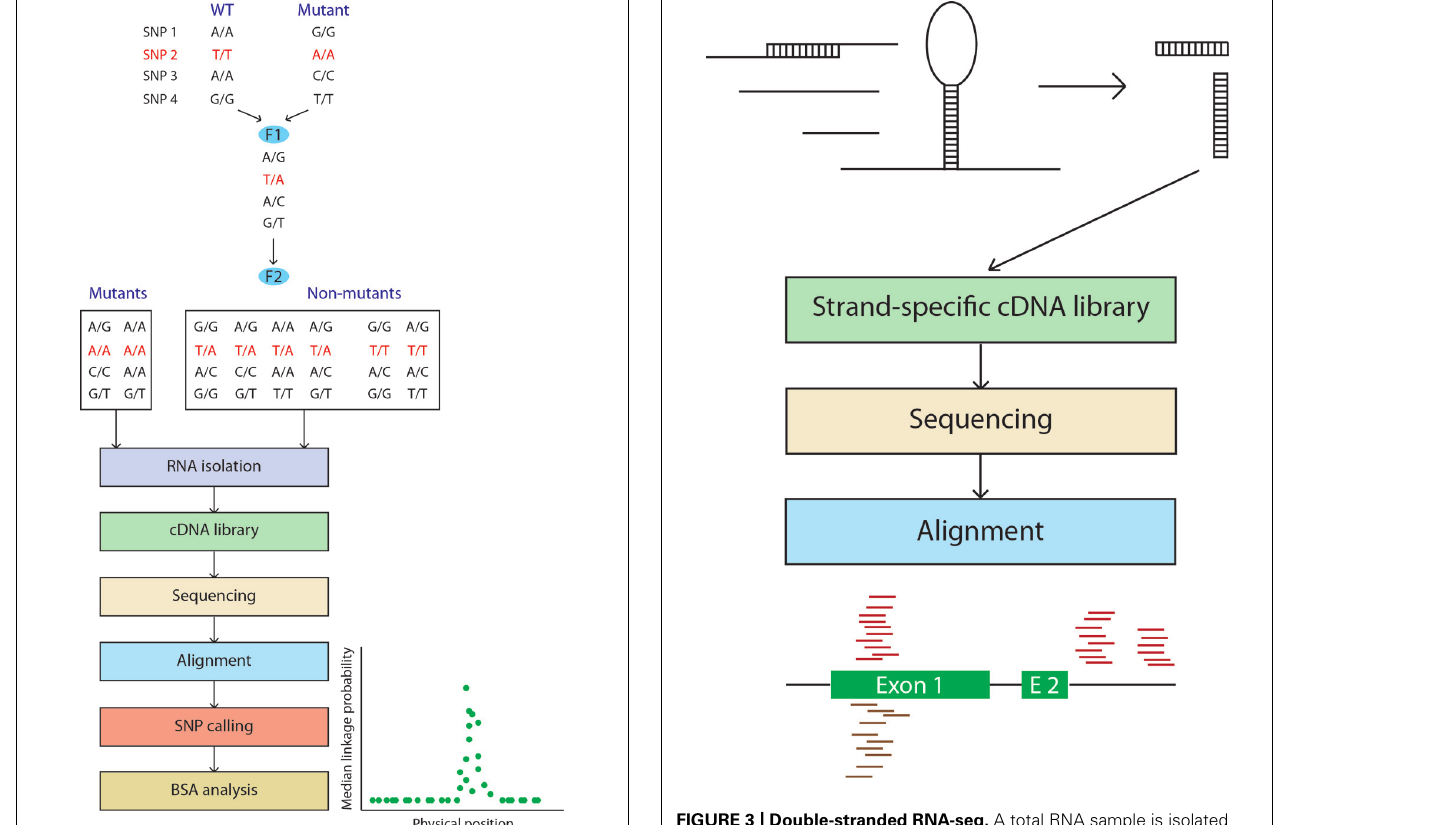
FIGURE 3 | Double-stranded RNA-seq. A total RNA sample is isolated and single-stranded RNA is digested with a single-strand-specific ribonuclease.The reads generated from the strand-specific cDNA library are aligned to the genomic sequence and intra or inter-molecular pairing can be inferred based on the strand specificity of the mapped